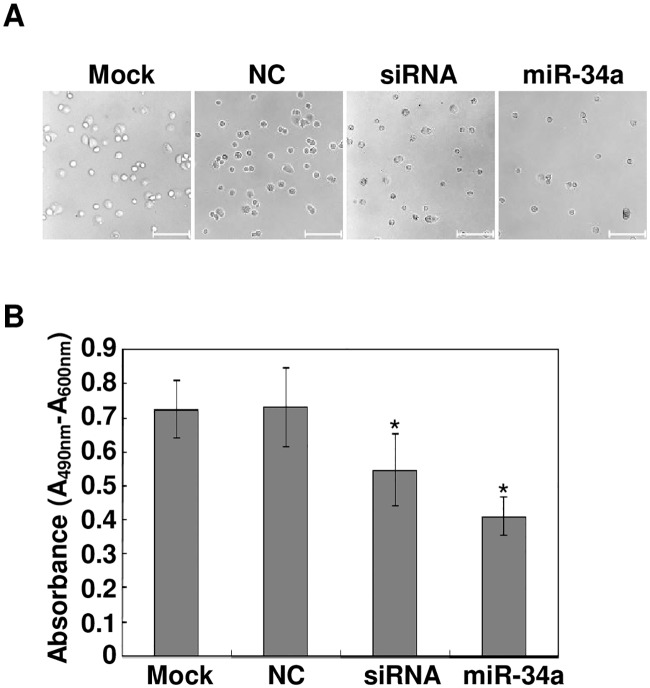
miR-34a expression or LGR4 knockdown attenuates ARPE-19 adhesion.Forty-eight hours after transfection with either a miR-34a, a LGR4 specific siRNA or a negative control (NC), ARPE-19 cells were harvested and re-seeded for 2 hours, and then unattached cells were removed by rinsing with PBS. (A) The phase-contrast images of attached cells were captured with an attached camera. Images represent those obtained in three independent experiments. Scale bar: 100 μm. (B) Attached cells were quantitated with the MTS assay. Data were expressed as mean ± SD of results from three independent experiments with each repeated in triplicates. *p < 0.05.